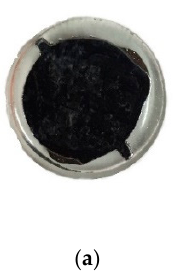
Figure 1. Specimen: ( a ) Top view; ( b ) side view.